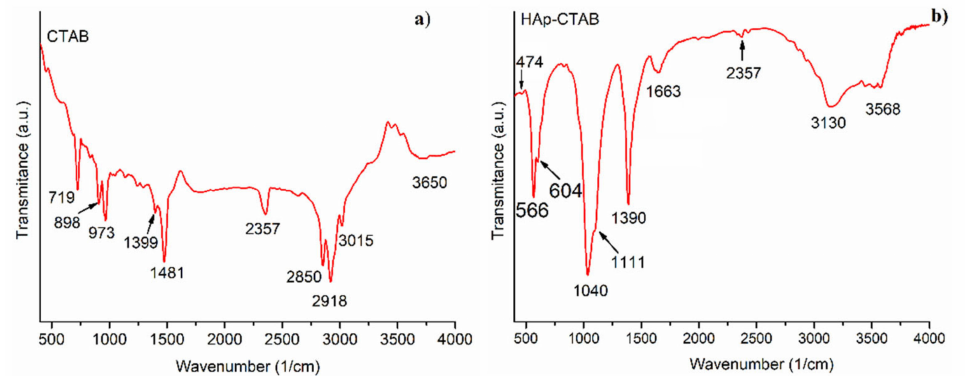
Figure 2. Fourier Transform Infrared Spectroscopy (FT-IR) spectra of CTAB ( a ) and HAp-CTAB composite ( b